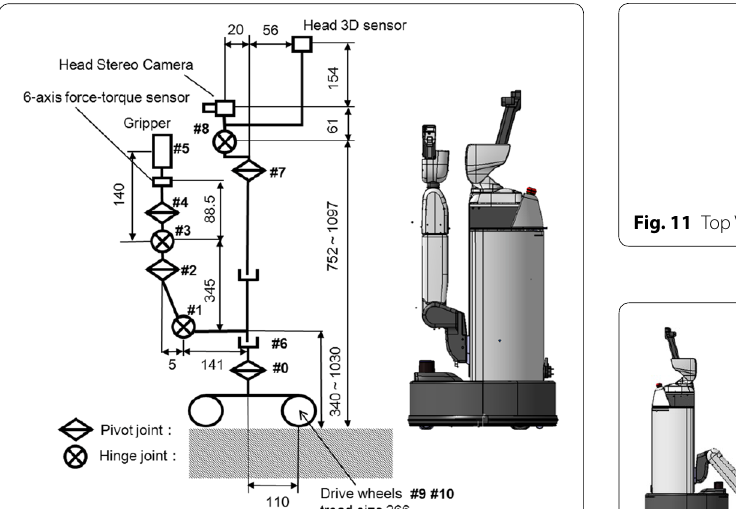
Fig. 9 Joint Configuration of HSR